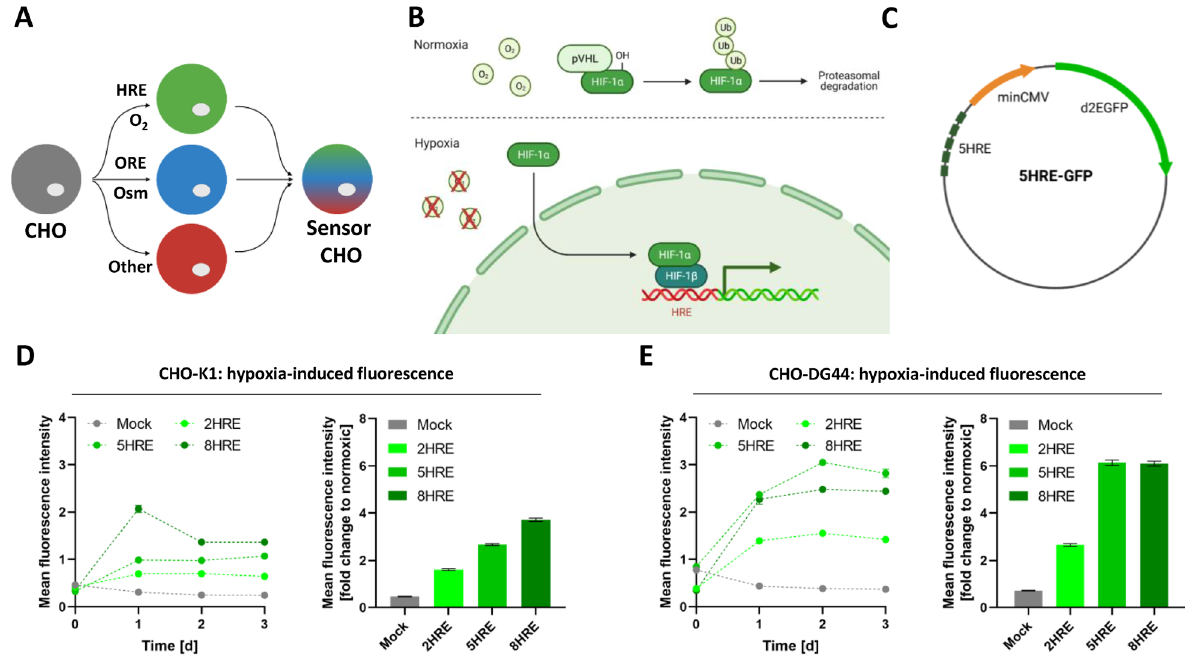
Figure 1. Establishment of a hypoxia-sensitive monitoring system. ( A ) Schematic overview of a CHO cell modified with different fluorescent expression vectors under the control of various response elements. ( B ) Hypoxia signaling pathway. ( C ) Schematic illustration of the hypoxia inducible d2GFP expression vector. ( D ) Flow cytometric analysis of shaken cultured CHO-K1 cells (left) and relative fold-change of mean fluorescence against the shaken cultured control (right). ( E ) Flow cytometric analysis of shaken cultured CHO-DG44 cells (left) and relative fold-change of mean fluorescence against the shaken cultured control